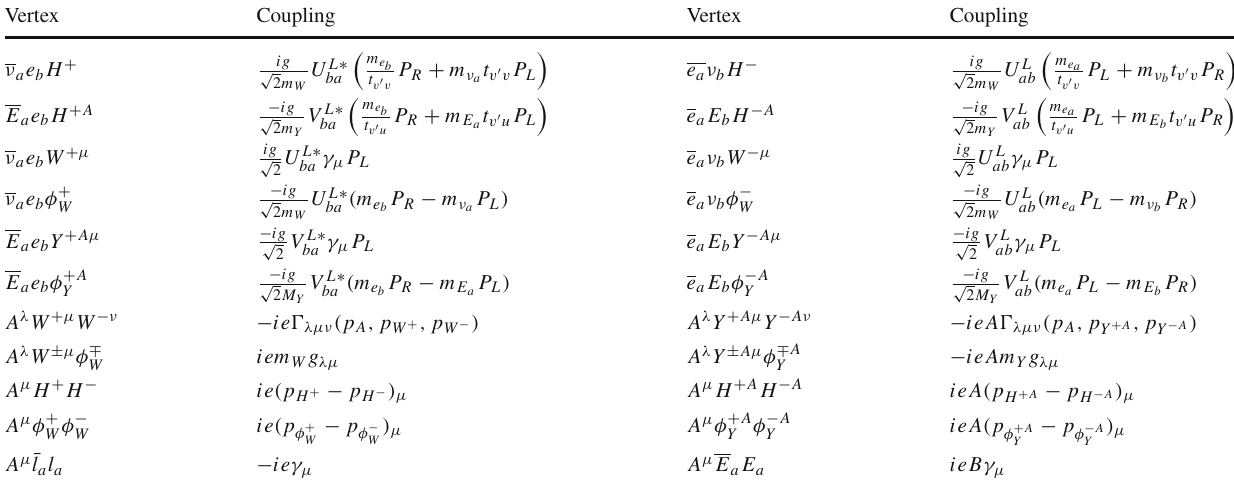
, p , p ) = ( p − p ) ν g λμ + ( p − p ) λ g μν + ( p − p ) μ g νλ . (cid:16) λμν ( p 1 2 3 1 2 2 3 3 1 Other notations are defined in the text